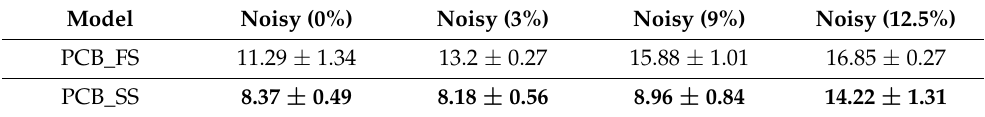
Table 8. Error rates (%) of unlabeled data with different noisy data ratios (Best result in bold). Model Noisy (0%) Noisy